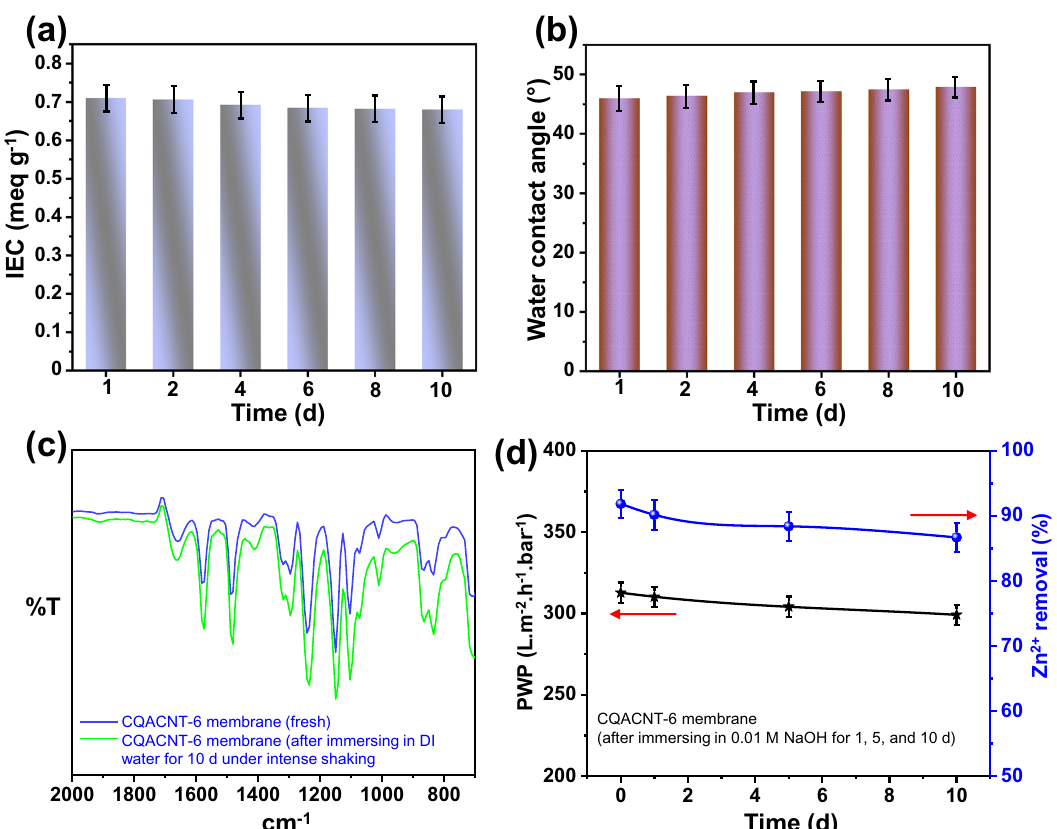
Fig. 10 Evaluation of membrane stability. a IEC of CQACNT-6 composite membrane dipped in DI water for different time intervals (1 – 10 d); b WCA of CQACNT-6 composite membrane dipped in DI water for different time intervals (1 – 10 d); c FT-IR spectra of CQACNT-6 composite membranes; d PWP and removal ef fi ciency of CQACNT-6 composite membrane during alkaline stability test for 1, 5, and 10 d. Error bars represent the standard deviation between three reported